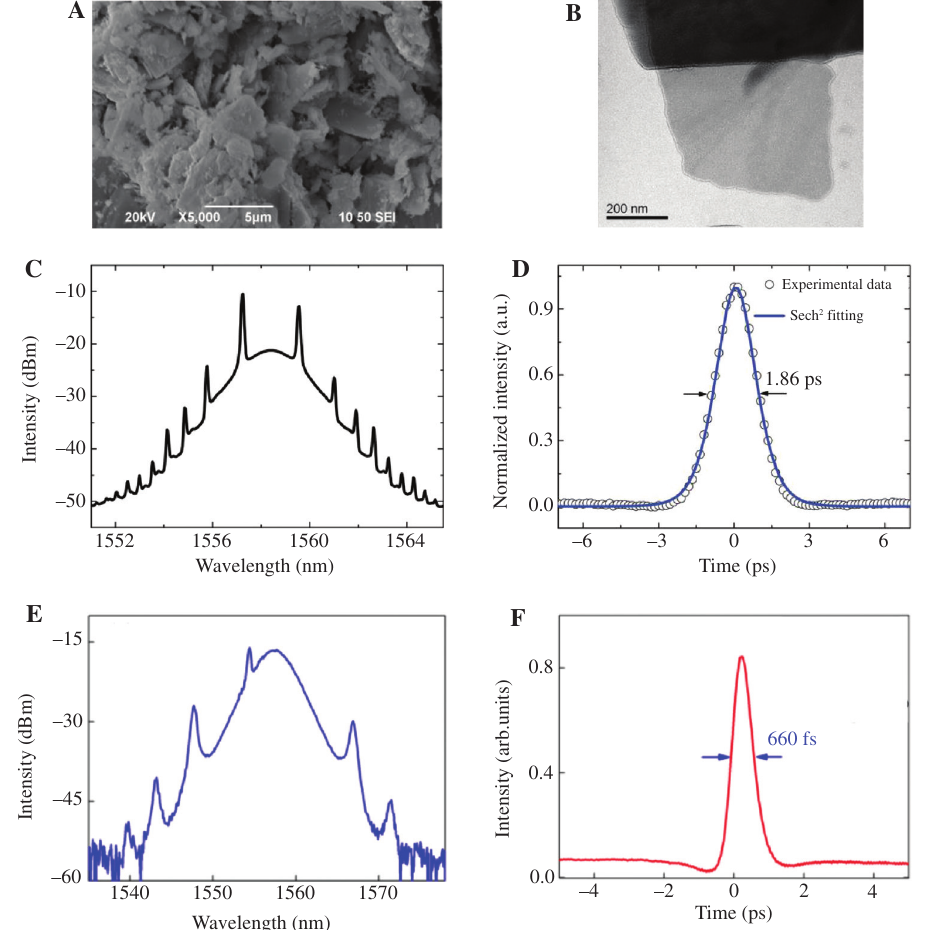
Te and Bi Se 2 3 2 3